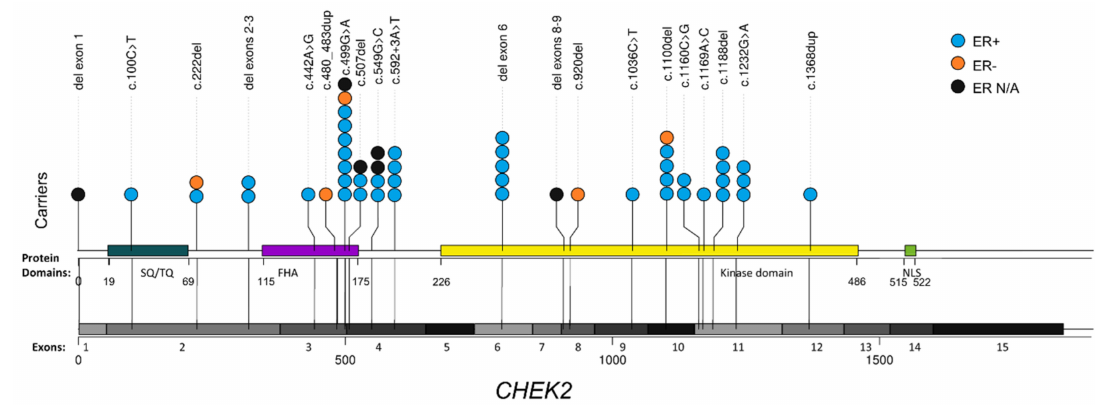
Figure 1. CHEK2 pathogenic variant spectrum found among Greek breast cancer patients. Abbreviation used: N/A, not available.